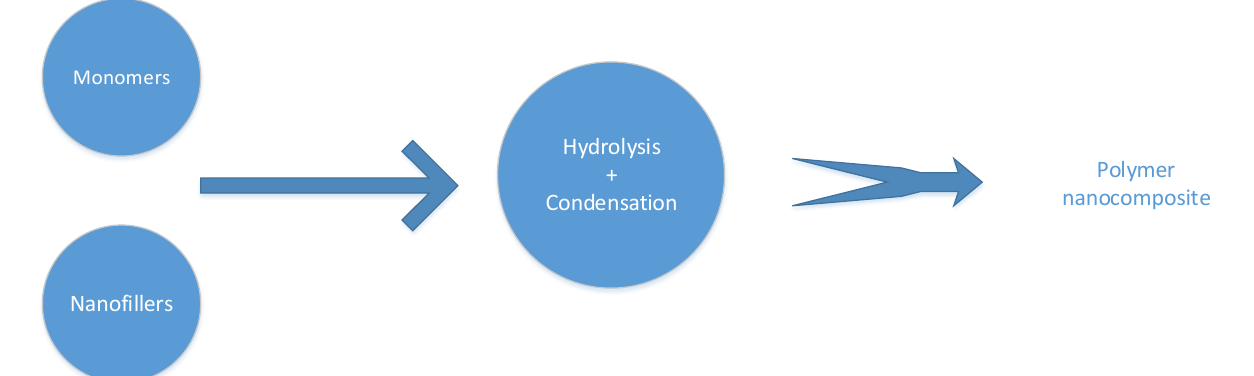
Figure 3. Steps to fabricate PNC with the sol-gel method.